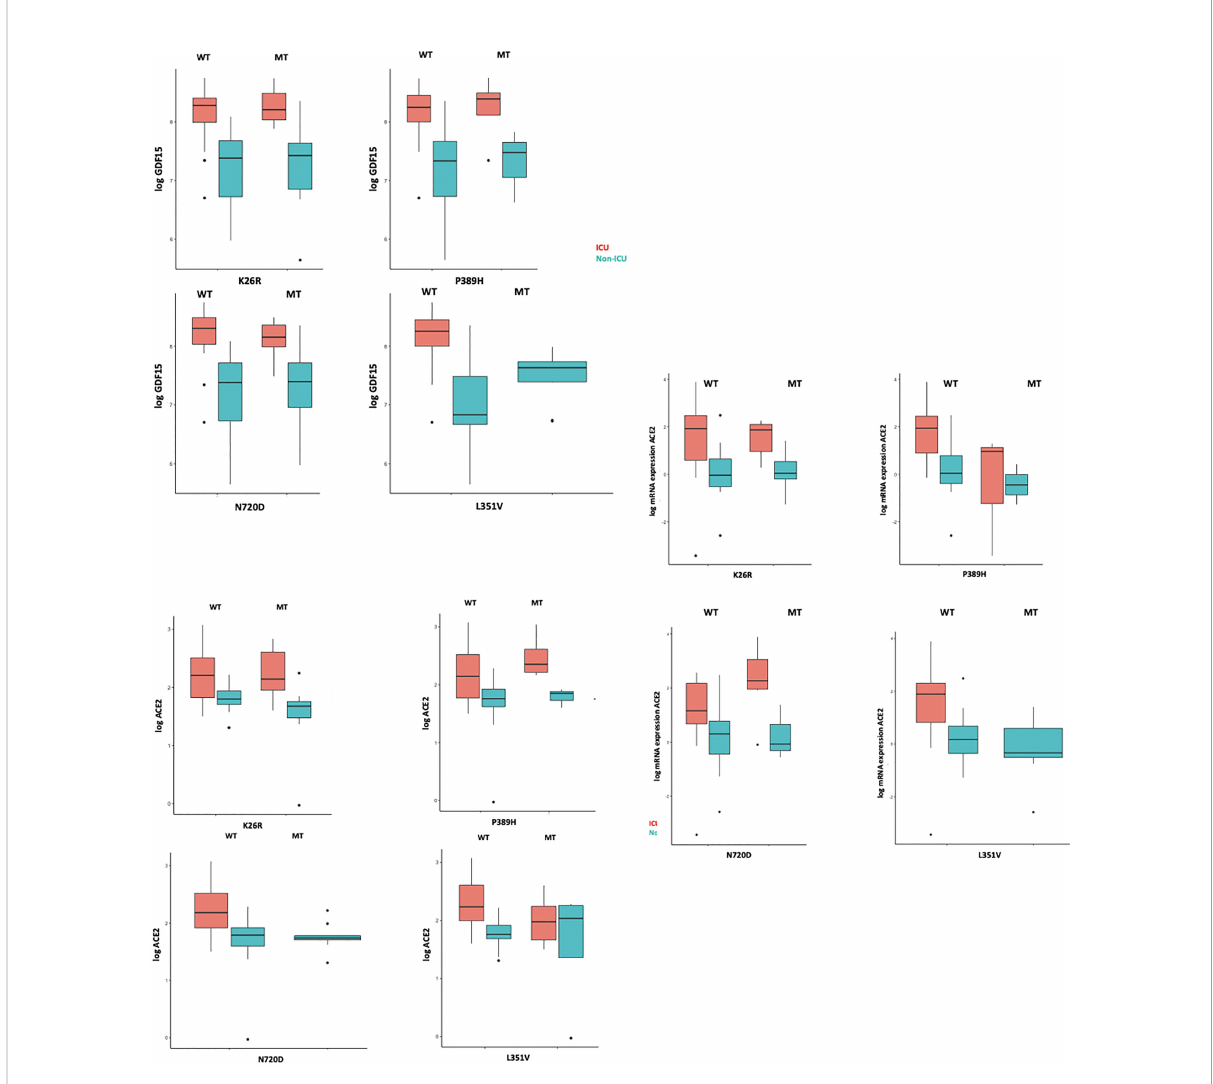
FIGURE 12 GDF15 and ACE2 levels among ICU and non-ICU COVID-19 patients and ACE2